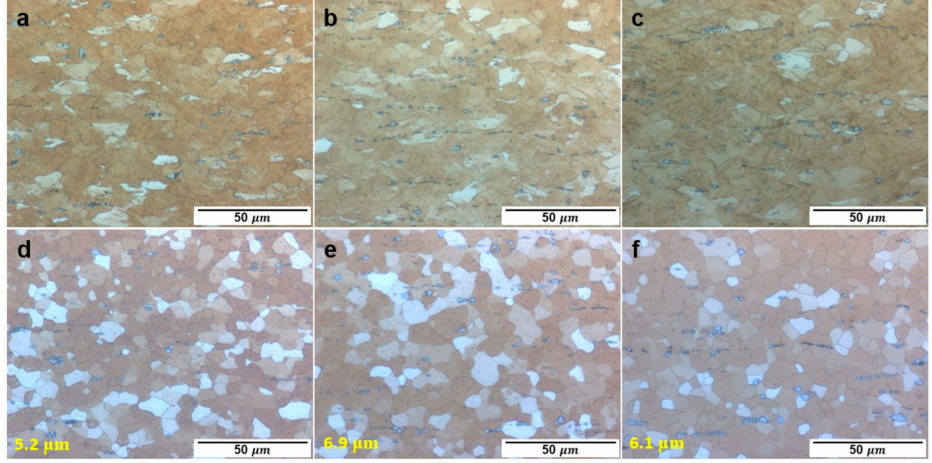
Figure 3. Optical micrographs of the ( a – c ) as-rolled and ( d – f ) annealed AZXW1000, 2000 and 3000 sheets,